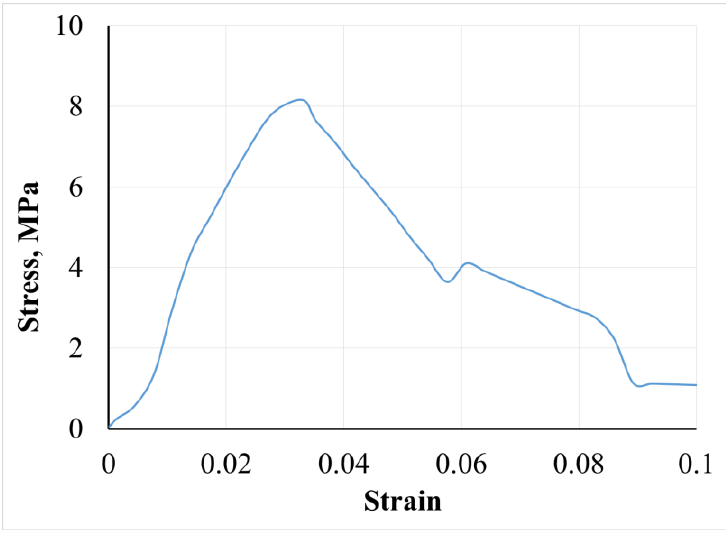
Figure 2. Stress – strain curve of drug-free casein-chitosan polyelectrolyte multilayer film. The FTIR spectra (Figure 3) were acquired by Nicolet iS10 system in the range from 650 to 4000 cm − 1 . In all the spectra the peaks at 1750 cm − 1 and 1186 cm − 1 correspond to C=O and C-O stretching of an ester group (PLA). Amide I and amide II bands, characteristic for casein, appear in the region 1680–1500 cm − 1 . The bands at 1130 cm − 1 , 1086 cm − 1 and 1051 cm − 1 resulted from the C-O stretching in C-OH and C-O-C bonds in substrate, casein, and glucosamine ring of chitosan. The band at 978 cm − 1 (dianionic phosphates), that is present in the casein spectrum, is not seen, suggesting an interaction with NH3+ of chitosan. Loading of benzydamin, betahistine and tolfenamic acid is confirmed by increasing the absorption in the region 1640–1450 cm − 1 and 2000–1800 cm − 1 due to the aromatic rings of the